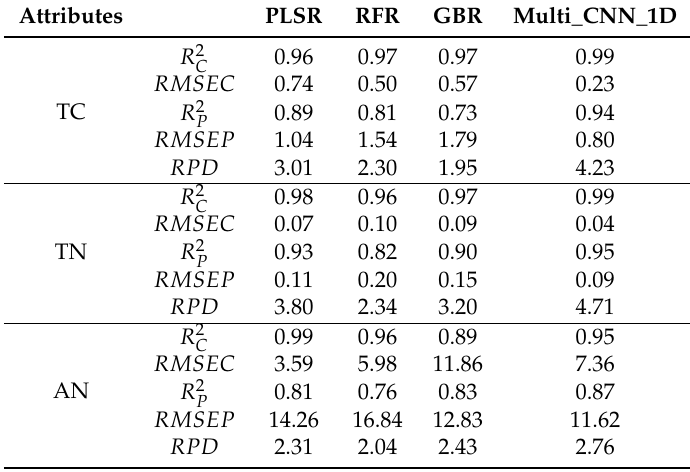
Table 3. Comparison of evaluation indexes of each model based on Small